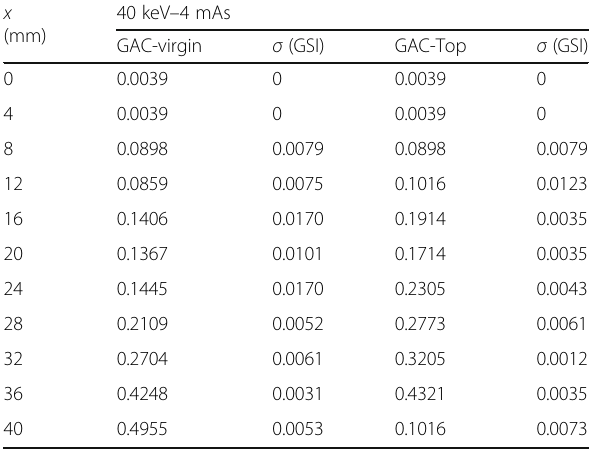
Table 2 Grey-scale intensity (GSI) of the X-ray radiography images for the GAC-Top and GAC-virgin at 40 keV – 4